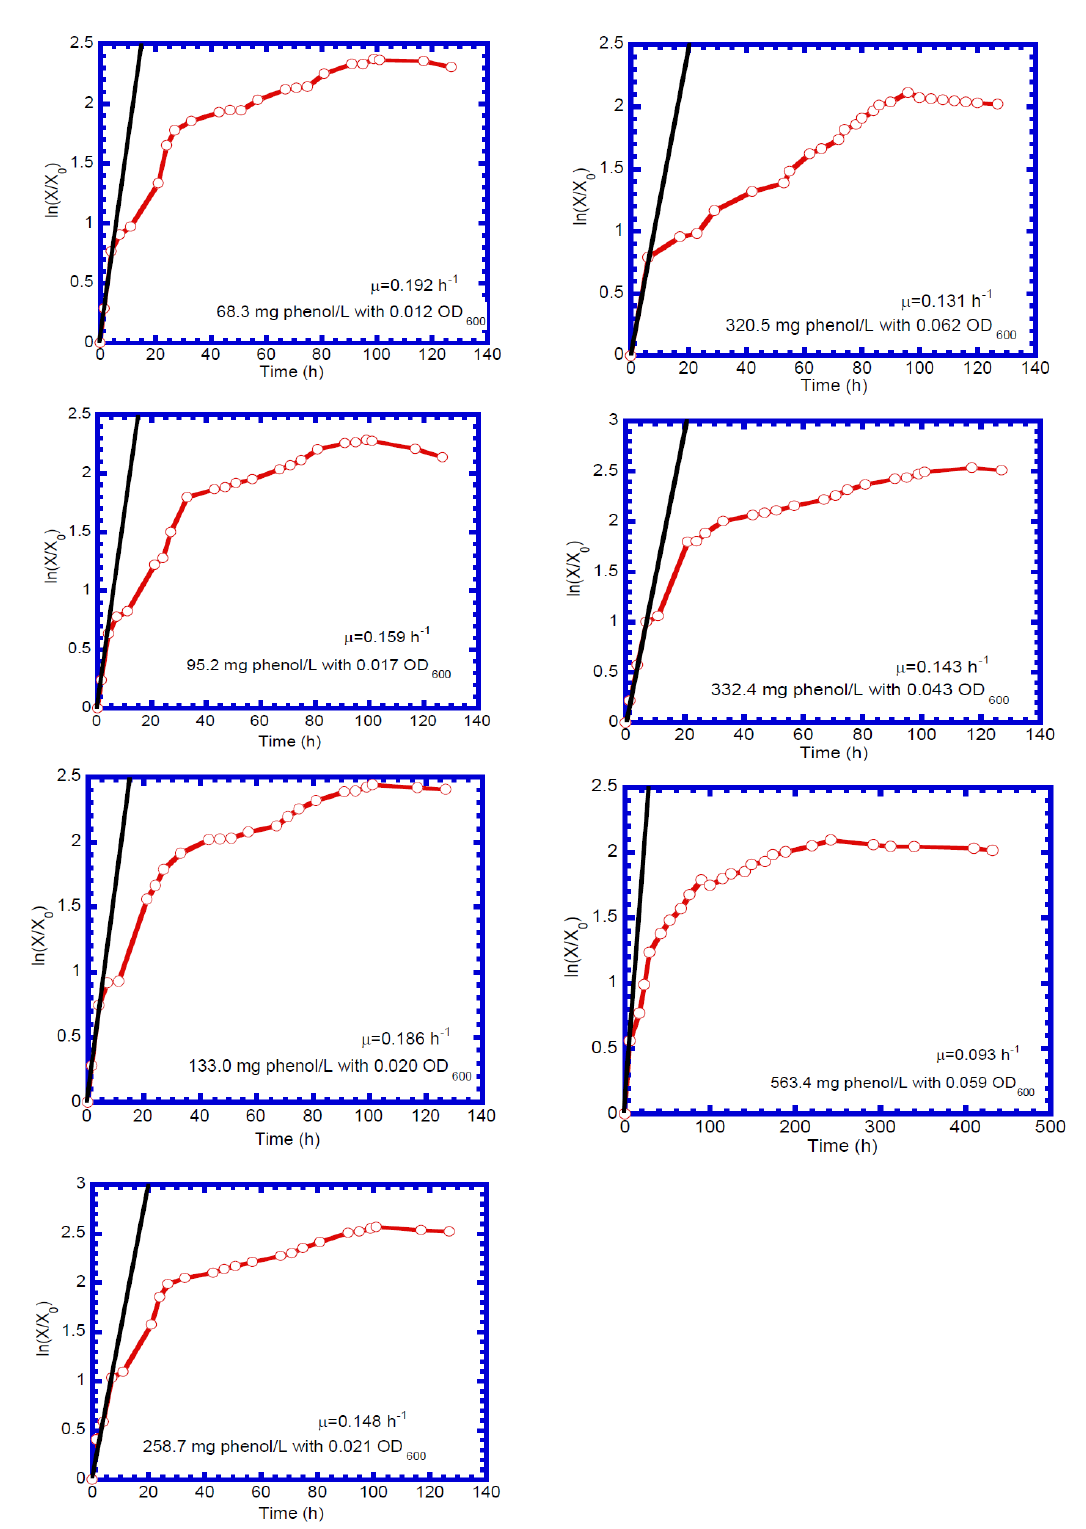
Figure 7. Time profile of growth curves to estimate specific growth rate at logarithmic growth phase, with di ff erent initial phenol and cell concentrations.